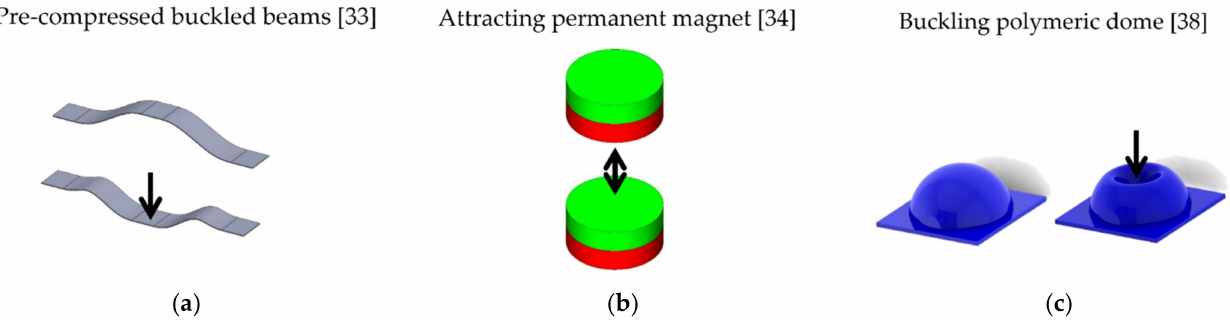
Figure 1. Examples of NBS elements: ( a ) pre-compressed buckled beam; ( b ) attracting permanent magnet; ( c ) buckling polymeric